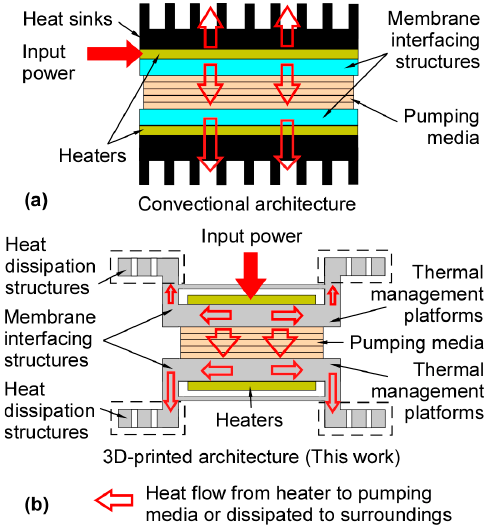
Figure 3. Comparison between previously reported KPs and the 3D-KP architecture. ( a ) The conventional architecture [11,12,24], where one surface of each heater is in full contact with a heat sink. ( b ) The 3D-KP architecture, which arranges the heaters further away from the heat dissipation structures. This reduces the waste of heat through the heat dissipation structure on the hot side, while not impeding heat dissipation on the cool side.